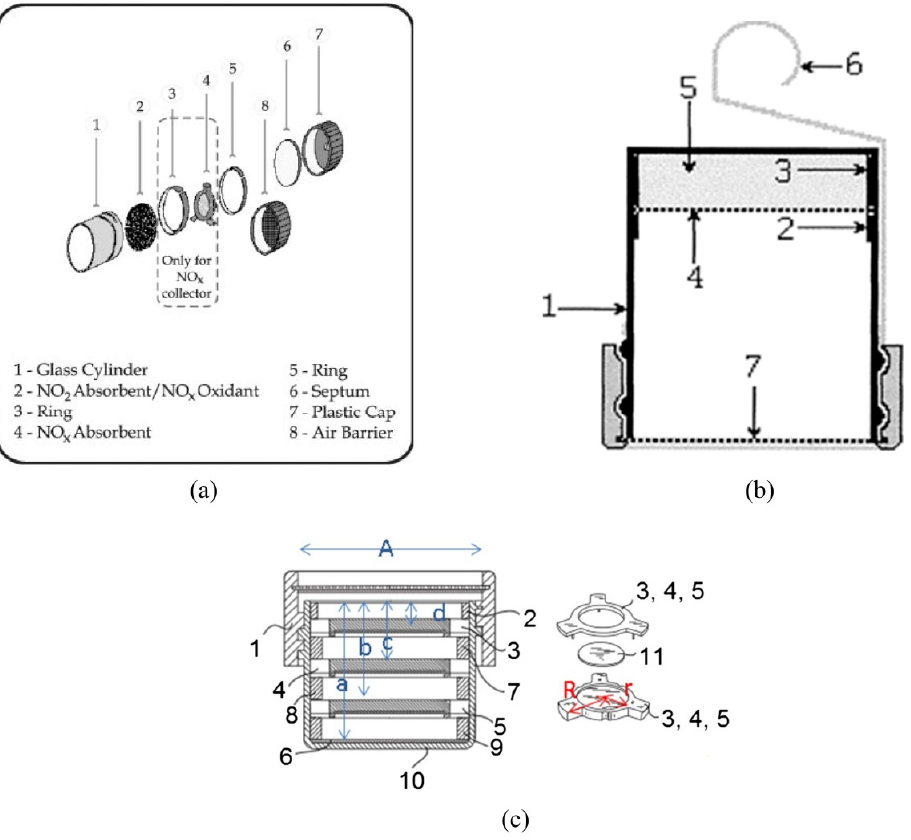
Figure 2. ( a ): Exploded scheme of Analyst NO 2 and Analyst NO x passive samplers [62]; ( b ): Structure of the ‘Analyst’ sampler, improved by Bertoni et al. [66] for BTX; ( c ): Exploded scheme of the multi ‐ pollutant sampler, according to the literature [67].